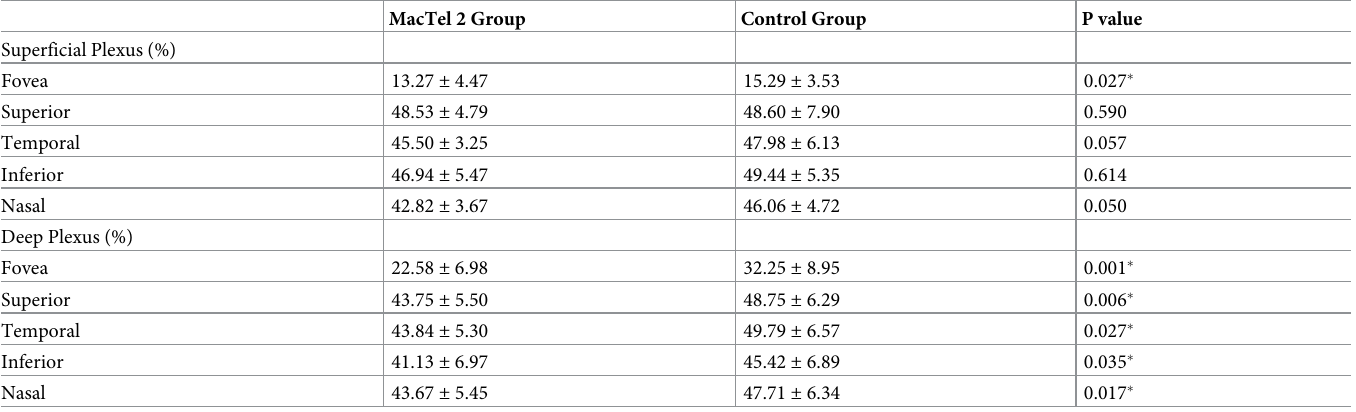
Table 1. Foveal and parafoveal vessel density of the superficial and deep plexuses evaluated by optical coherence tomography angiography in the MacTel 2 group and control group. MacTel 2 Group Control Group P value Superficial Plexus